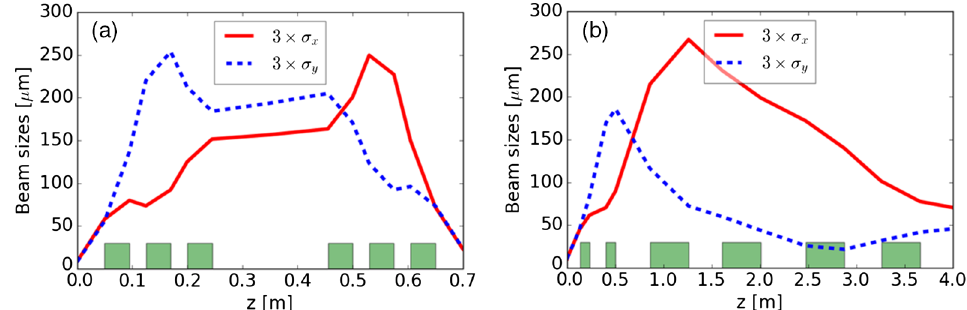
FIG. 9. Evolution of the beam size (3 sigmas) along the optimized LETL (a) and HETL (b). The quadrupoles are symbolized by the green